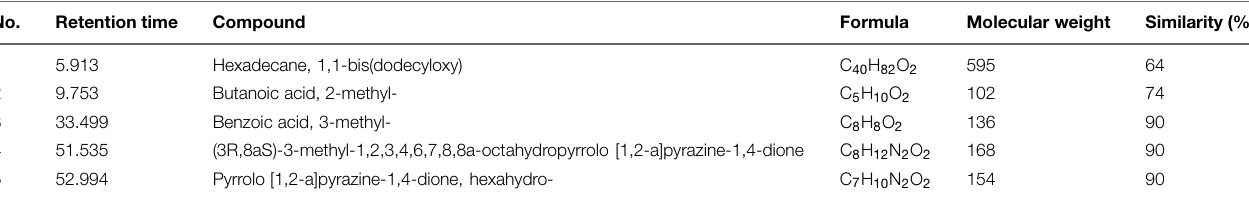
TABLE 3 | Compounds identified from MUSC 149 T extract through Gas chromatography – mass spectrometry (GC–MS). No.